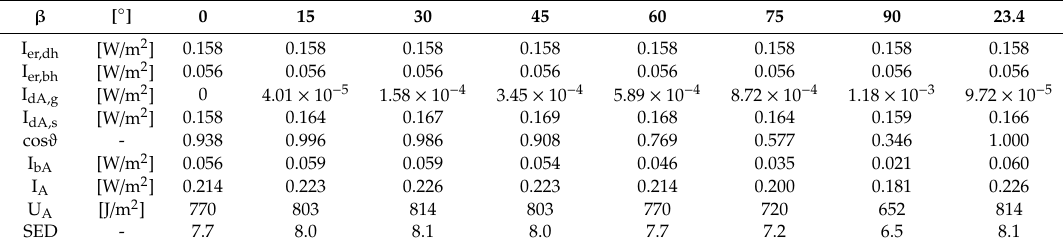
Table 4. Calculation results for sloped surfaces facing the south direction (21 June, solar noontime).